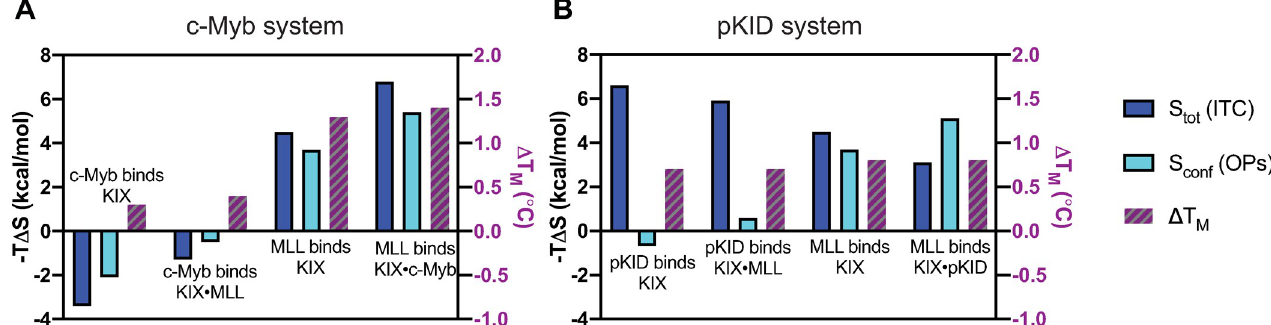
Fig 6. Changes in total entropy upon binding from previously-published ITC experiments (dark blue) [23] compared to KIX conformational entropy changes calculated here using methyl order parameters (OPs) from molecular dynamics simulations (light blue) for (A) the c-Myb system and (B) the pKID system. Changes in melting temperatures determined from DSF are shown on the right y-axis